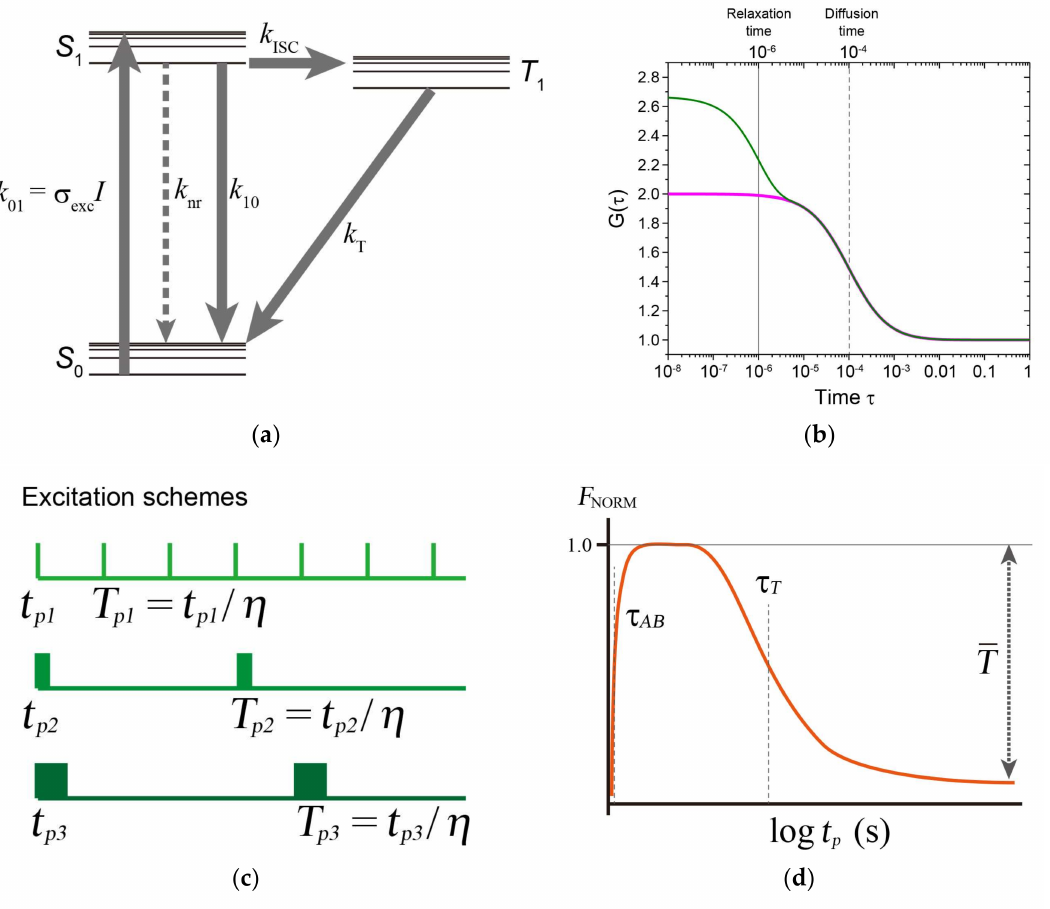
Figure 4. Transient state monitoring with FCS or TRAST. ( a ) Jablonski diagram showing a three-state electronic model, including the ground singlet state ( S 0 ), the first excited singlet state ( S 1 ), and the lowest triplet state ( T 1 ). Rate constants: k 01 , for the excitation from S 0 to S 1 ; k 10 , for the relaxation process with irradiation from S 1 to S 0 ; k nr , for the relaxation process without irradiation from S 1 to S 0 ; k ISC , for the intersystem crossing from S 1 to T 1 ; and k T , for the relaxation from T 1 to S 0 . k 01 can be written as σ exc I , where σ exc is the excitation cross-section, and I is the excitation intensity. ( b ) Simulated autocorrelation functions G ( τ ) as the function of time, τ , in a one-component diffusion model (magenta) or one including one-component exponential relaxation (green), where the exponential relaxation time is 10 − 6 s (gray line); the diffusion time is 10 − 4 s (gray dashed line); the component of the exponential relaxation time is 0.4; structure parameter, the ratio between lateral and axial length of the detection volume, is 5; and the number of molecules is 1. ( c ) Excitation schemes of excitation pulses at different pulse times ( t p1 , t p2 , and t p3 ) and pulse intervals ( T p1 , T p2 , and T p3 ) during duty cycle, η . ( d ) Normalized fluorescence intensity when the transient state cycle is assumed to be the combination of S 0 , S 1 , and T 1 shown in ( a ) as a change of pulse width. τ AB , τ T , and T refer to the anti-bunching relaxation time (dashed line), the triplet relaxation time (dashed line), and a steady-state established with a constant population of the lowest triplet state (dark grey two-way arrow),